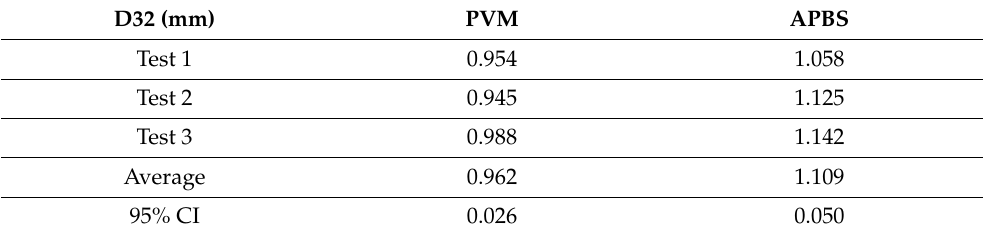
Table 4. Sauter mean bubble diameter measured with PVM and APBS probes.